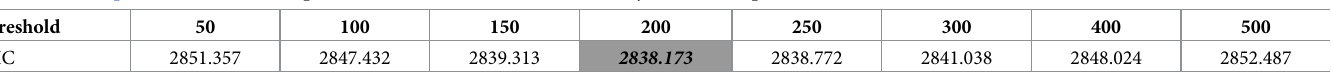
Table 5. DIC (Eq 11) of stochastic Gompertz model (M2) fit to data for Germany for various splice thresholds.